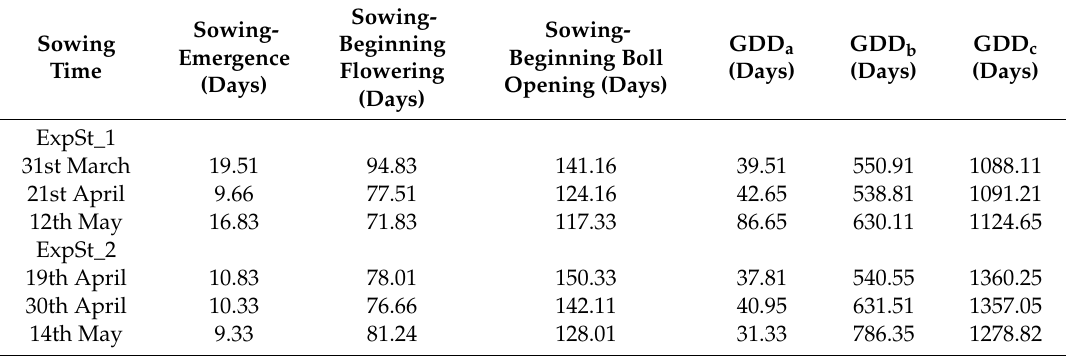
Table 4. E ff ect of sowing times on phenology of upland cotton cultivars during